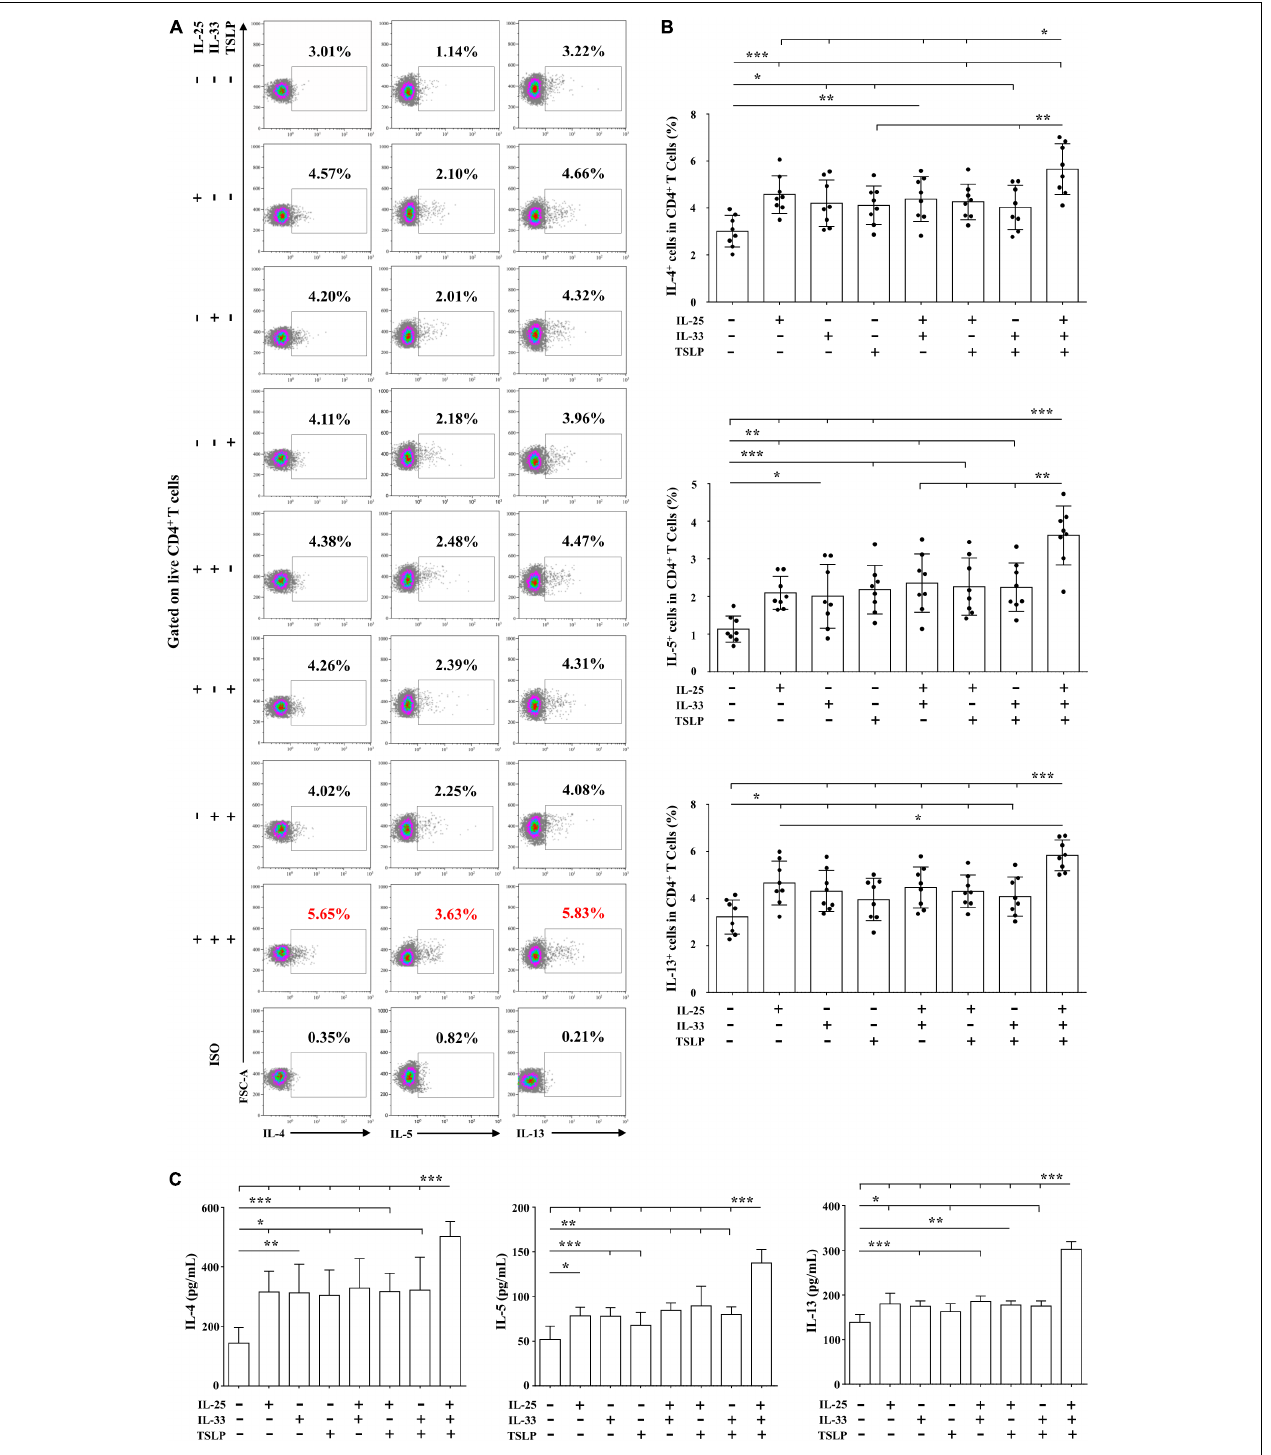
FIGURE 5 | Effects of IL-25, IL-33, and TSLP on the pro-Th2 function of AR-derived mo-DCs. (A) Representative flow plots of IL-4, IL-5, and IL-13 expression by CD4 + T cells from HC subjects ( n = 8) co-cultured for 5 days with Der.p1-induced mo-DCs from AR subjects ( n = 8). Prior to co-culturing, Der.p1-induced mo-DCs were stimulated with IL-25, IL-33, and TSLP, singly or in combination, for 24 h. (B) Quantification of percentages of IL-4 + , IL-5 + , and IL-13 + cells in CD4 + T cells. (C) Protein levels of IL-4, IL-5, and IL-13 in the supernatants of co-cultured cells as measured by ELISA ( n = 6). Data are expressed as means ± SD. Significant differences were tested using the paired t -test between control and cytokine stimulation groups, and using Student’s t -test between cytokine stimulation groups. * P < 0.05, ** P < 0.01, *** P < 0.001.